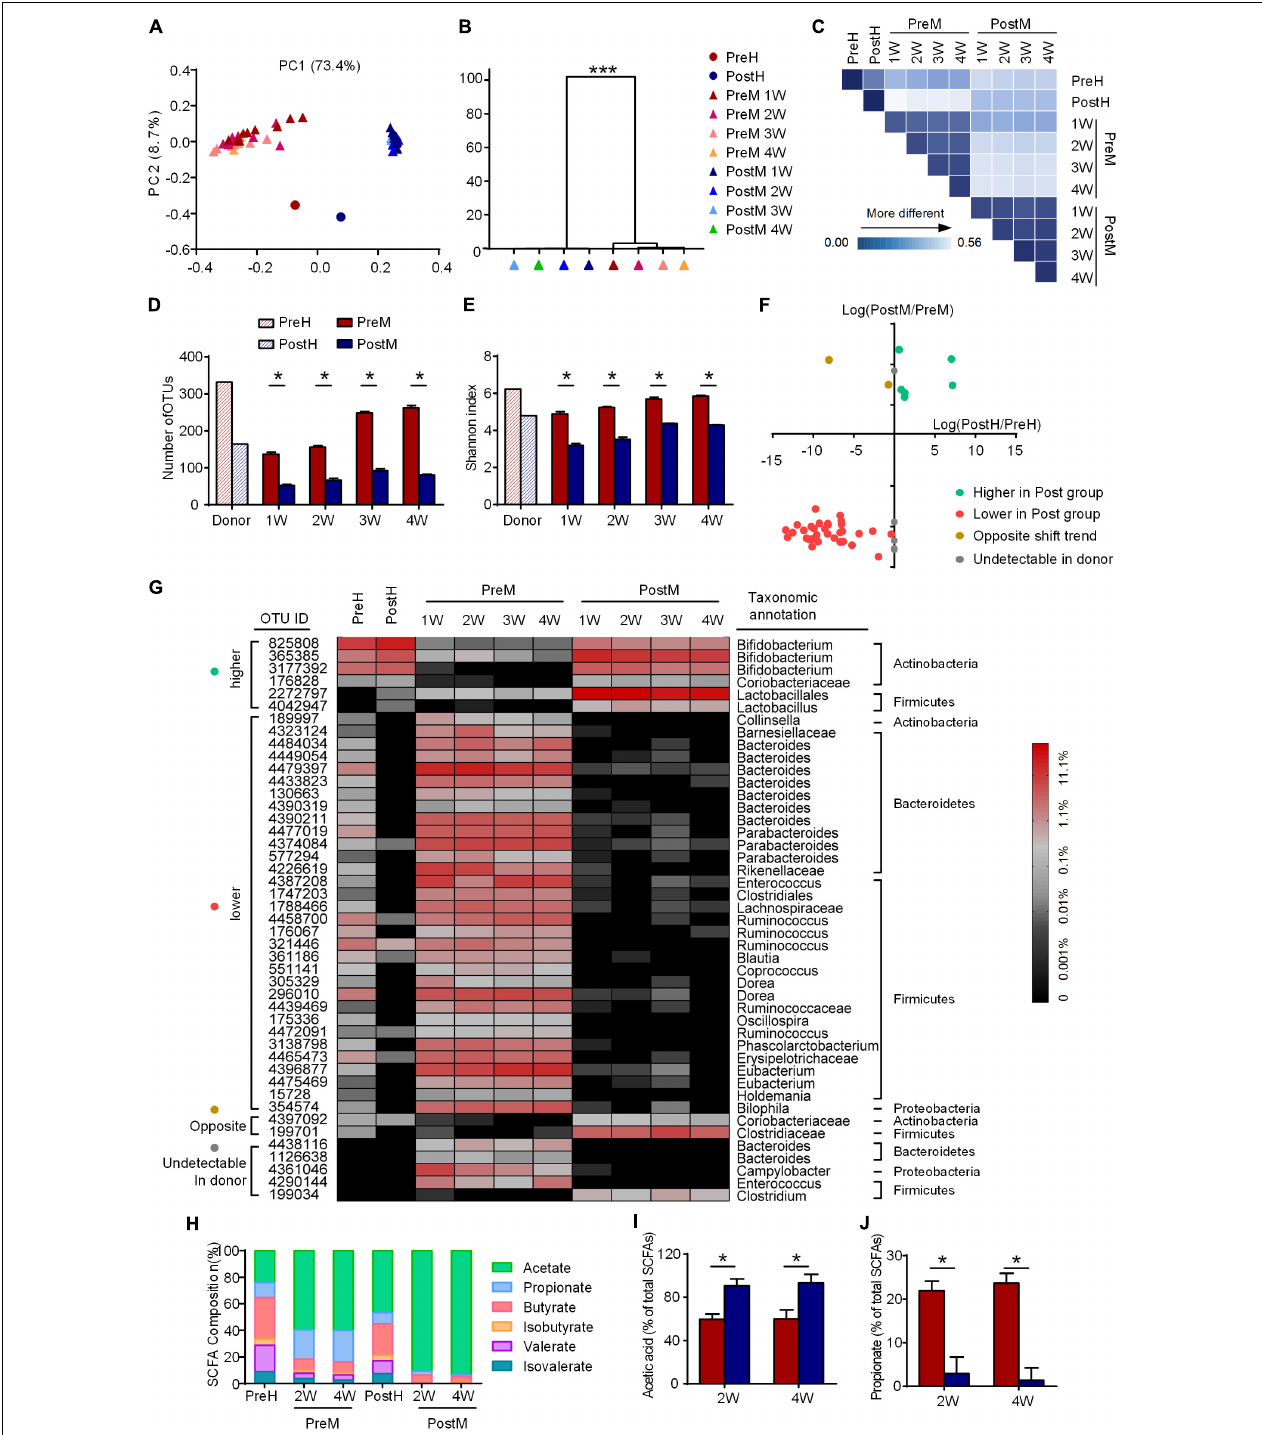
FIGURE 2 | The features of gut microbiota are transferrable from the human donor to the GF mice. (A) Weighted UniFrac PCoA plot and (B) multivariate analysis of variance analysis of gut microbiota based on OTUs, ∗∗∗ P < 0.001; (C) weighted UniFrac distances of gut microbiota between the donor and recipients; (D) OTU richness; (E) Shannon index; (F) abundance variation of 45 discriminatory OTUs in the donor and recipients; (G) heat map of 45 discriminatory OTUs, with the color of the spot corresponding to the normalized and log-transformed relative abundance; (H) the composition of SCFA in feces of donor and the cecum of the recipients; (I) relative concentrations of acetate; and (J) relative concentrations of propionate. For the recipient groups, n = 9 on the 1 st and 2 nd week; n = 4 or 5 on the 3 rd and 4 th week. In D,E,I , and J , data are shown as the mean ± SEM and were compared between groups using the Mann–Whitney U test. ∗ P < 0.05. PC, principal coordinate; OTU, operational taxonomic unit; SCFA, short chain fatty